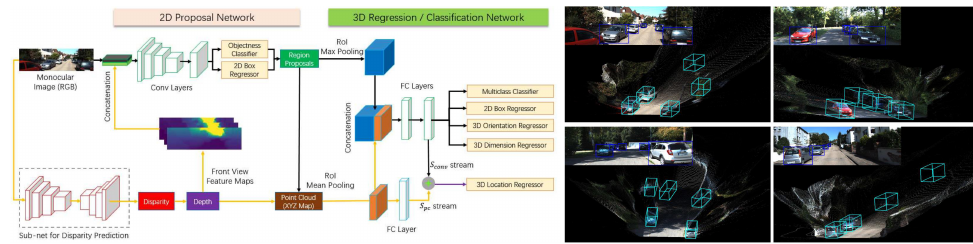
Figure 7. MF3D for 3D object detection from monocular images